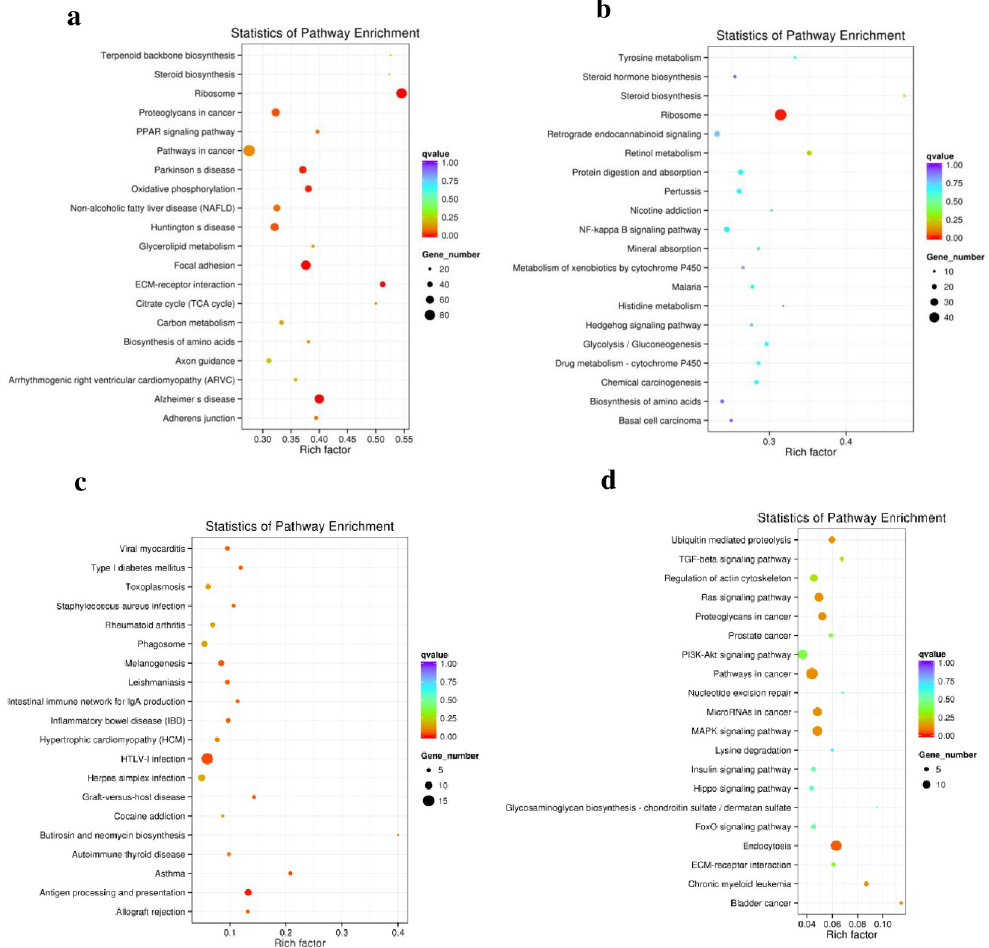
Fig 6. Kyoto Encyclopedia of Genes and Genomes (KEGG) enrichment analysis of differentially expressed genes between day 4 and day 0. (a) KEGG enrichment analysis of differentially expressed mRNAs. (b) KEGG enrichment analysis of differentially expressed lncRNAs with their trans-acting mRNA. (c) KEGG enrichment analysis of differentially expressed lncRNAs with their cis-acting mRNA. (d) KEGG enrichment analysis of differentially expressed circRNAs.